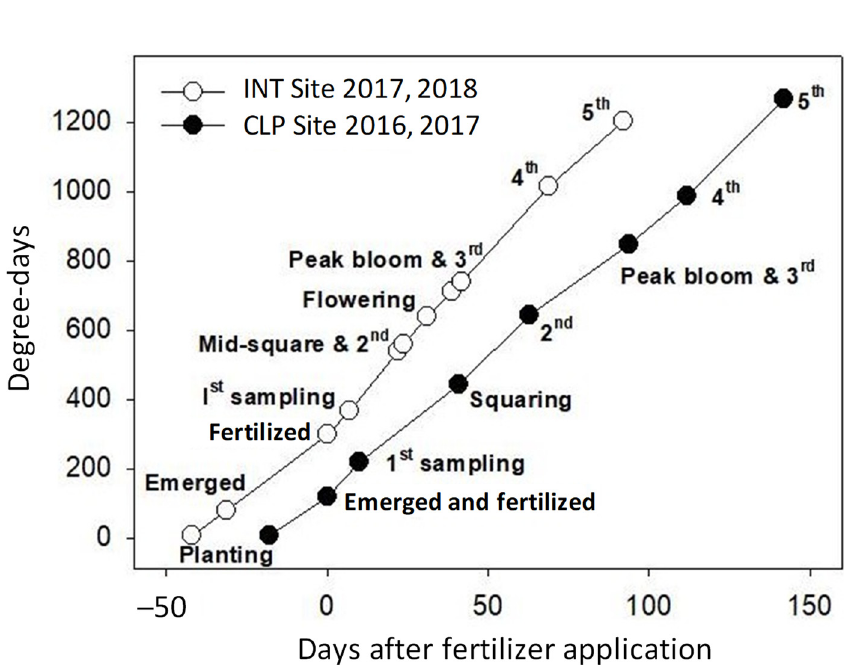
Figure 1. Development of the cotton crop in the 2016/17 (CLP) and 2017/18 (INT) growing seasons. Time taken for the crop to reach key growth stages (degree-days) was plotted against time (days) after fertilizer application. Numerals indicate the soil sampling sequence. Development and sampling at CLP was similar at NAS, and development and sampling at INT was similar at SAT.